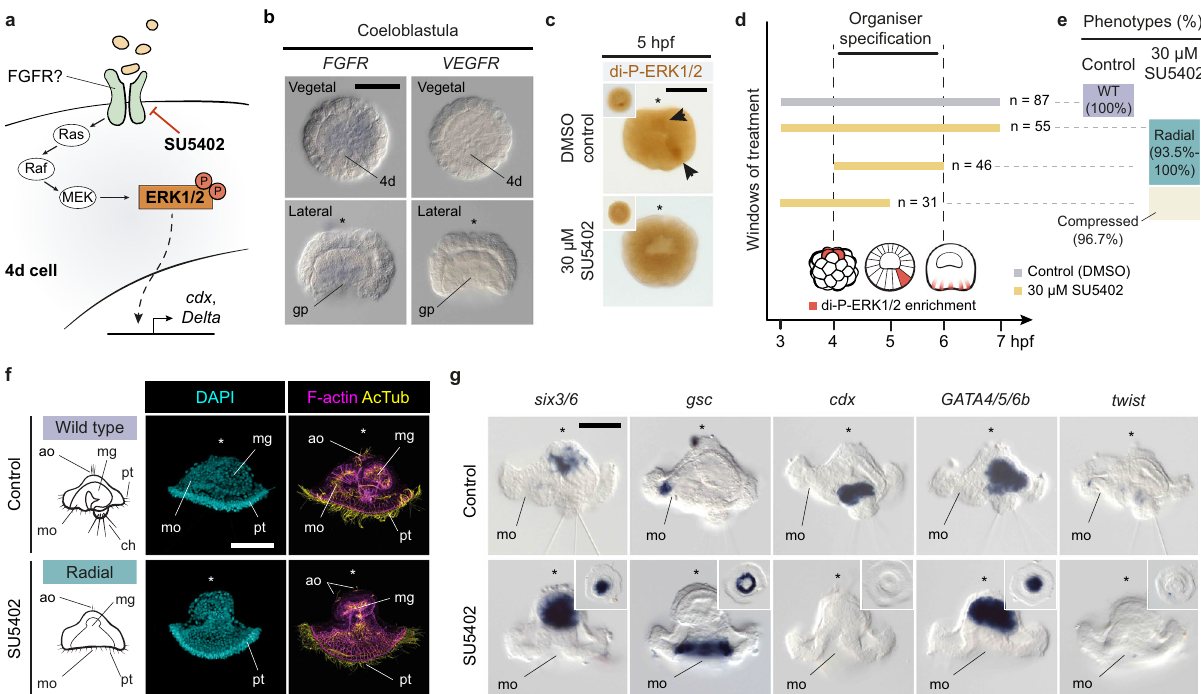
Fig. 8 FGFR signalling regulates ERK1/2 di-phosphorylation in 4d. a Schematic drawing of the downstream intracellular FGFR pathway. The drug SU5402 speci fi cally inhibits receptors tyrosine kinase of the type FGF/VEGF, which can signal through the ERK1/2 signalling cascade. b Whole mount in situ hybridisation for FGFR and VEGFR at the coeloblastula stage in O. fusiformis . FGFR is expressed weakly at the gastral plate at the time of 4d- instructed posterior re-pattering. However, VEGFR, which SU5402 treatment can also inhibit, is not expressed at this stage. c Whole mount immunohistochemistry against di-phosphorylated ERK1/2 (di-P-ERK1/2). SU5402 treated embryos lose ERK1/2 enrichment in a vegetal micromere at 5 h post fertilisation (hpf). Main images are lateral views and insets are vegetal views. d Schematic representation of the drug treatment windows conducted in this study, targeting the period of 4d speci fi cation (5 hpf). Number of cases is shown to the right of each bar specifying the time interval. e Distribution and percentages of the larval phenotypes observed for each window and experimental condition (WT, wild type). f Lateral views of z-stack projections of control and 4 – 6 hpf SU5402 treated embryos fi xed at the larval stage and stained with DAPI (nuclei), phalloidin (F-actin) and Acetylated Tubulin (cilia). Treated larva show a phenocopy of the U0126 radial larval phenotype. On the left, schematic diagrams of lateral views of the controls and radial larva phenotypes. g Lateral views of whole mount in situ hybridisation of fi ve cell type markers in control and 4 – 6 hpf SU5402 treated embryos fi xed at the larval stage. Treated embryos develop into radialised larvae with expanded oral ectodermal markers ( gsc ), reduced apical ectodermal markers ( six3/6 ), lack of hindgut and trunk mesodermal genes ( cdx and twist , respectively) and normal midgut markers ( GATA4/5/6b ). Insets are ventral views. In b , c , f and g , asterisks point to the apical pole. For d – g , Supplementary Table 12 reports detailed numbers. Scale bars are 50 μ m. Schematic drawings are not to scale. an anus, ao apical organ, ch chaetae, gp gastral plate, mg midgut, mo mouth, pt Orthology assignment and domain architecture analyses . Generally, gene orthology was based on the functional annotation of O. fusiformis gene repertoire, based on BLAST searches against SwissProt database and Panther searches (functional annotation available at the repository https://github.com/ChemaMD/ OweniaGenome). Protein sequences for ERK1/2 and ERK5, WNT ligands, RHOX and related homeoboxes, DLL and JAGGED, FOXH and FOXF genes and FGFR and VEGFR were retrieved by mining publicly available transcriptomes and databases. Multiple protein alignments (available in Supplementary Data 1) were constructed with MAFFT v.7 in automatic mode 63 and poorly aligned regions were removed with gBlocks version 0.91b 64 . Maximum likelihood trees were constructed with either RAxML v.8.2.11 65 or FastTree 66 and visualised with FigTree (https:// github.com/rambaut/ fi gtree/). InterProScan 5 67 was used to perform the protein domain composition of DLL.